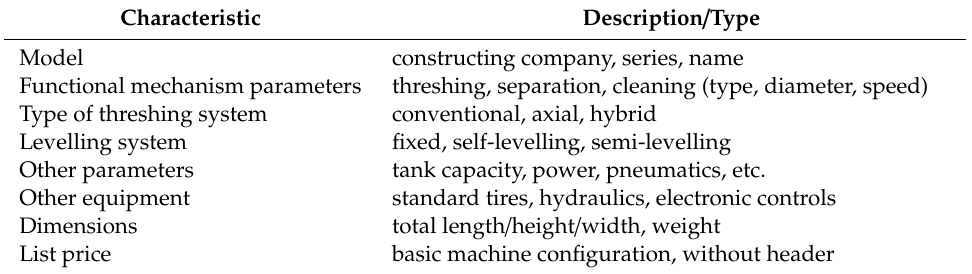
Table 1. Description of the considered data related to the harvesting machines according to the information provided by